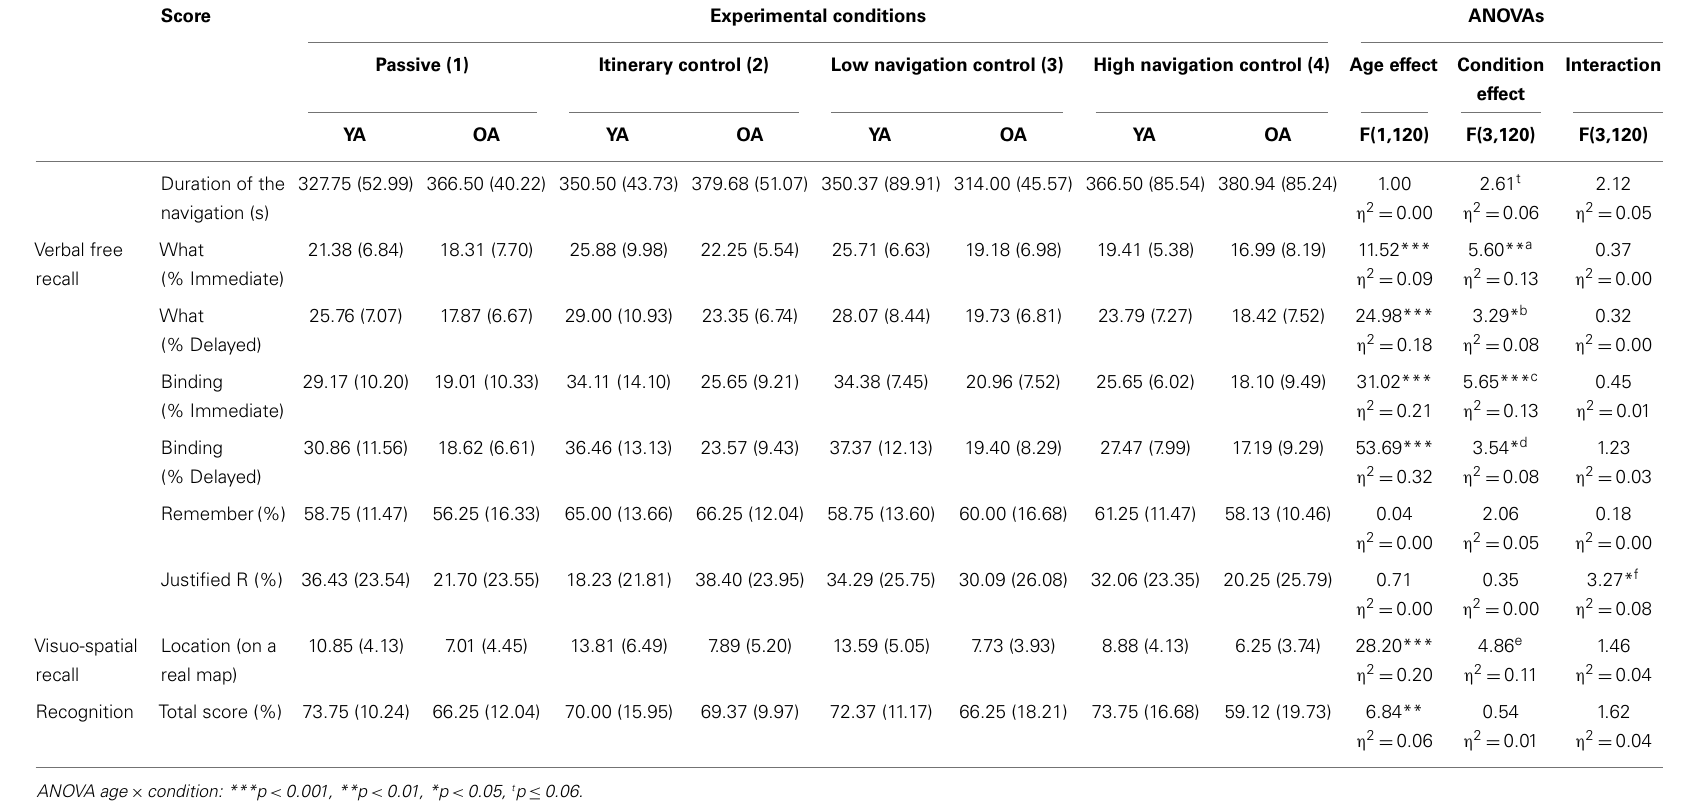
Table 2 | Mean and SD of theVR–MEM test according to the age-group and the experimental condition and results of theANOVAs